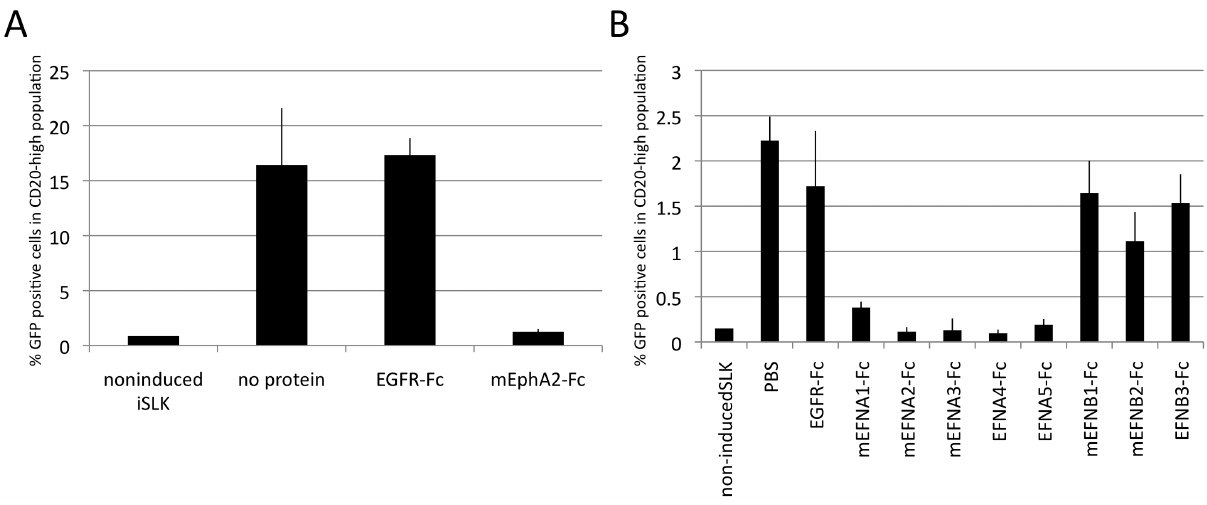
Figure 6. Inhibition of KSHV cell-cell transmission into a B cell line by soluble Eph proteins and soluble Ephrins. BJAB B cells were co- cultured for 10 days ( A ) or 4 days ( B ) with lytically induced iSLK.219 cells in the presence of the indicated proteins at 5 m g/ml. The cells were then harvested and analyzed for expression of the GFP reporter gene by flow cytometry. BJAB cells were distinguished from iSLK.219 cells by a two-step gating strategy, first selecting by FSC/SSC for the B cell population and then by gating for CD20 expression. The percentage of green CD20-positive cells from co-culture with non-induced iSLK cells represents the assay background. PBS and EGFR-Fc serve as controls. (n=3; error bars indicate sd).